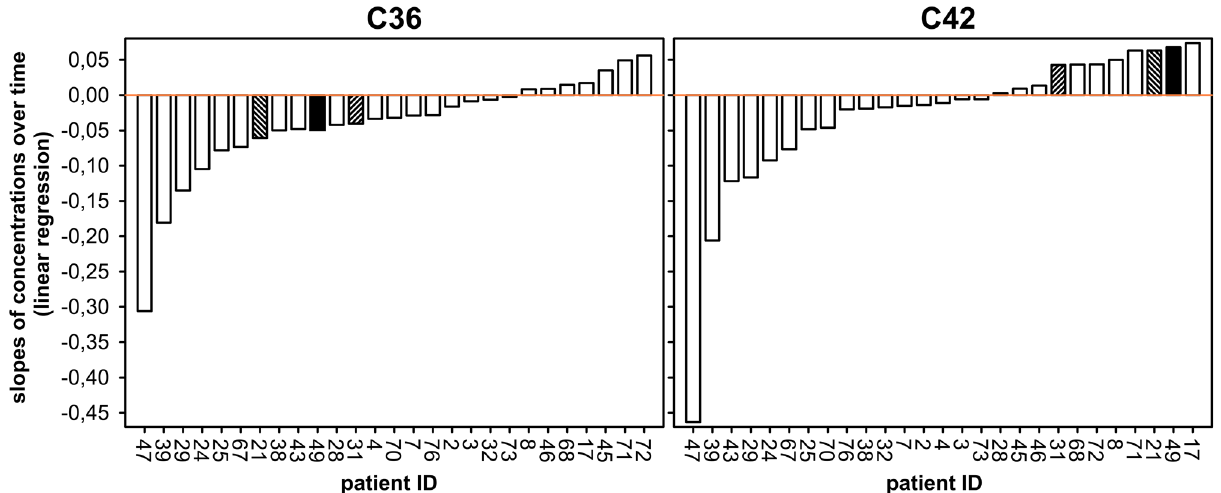
Figure 3. Development of C36 und C42 concentrations in septic patients. To obtain trends over time, linear regression analyses were conducted for patients with at least three samples collected during their stay at the ICU (cohort B, n = 27). Patients exhibiting opposite trends for C36 and C42 are